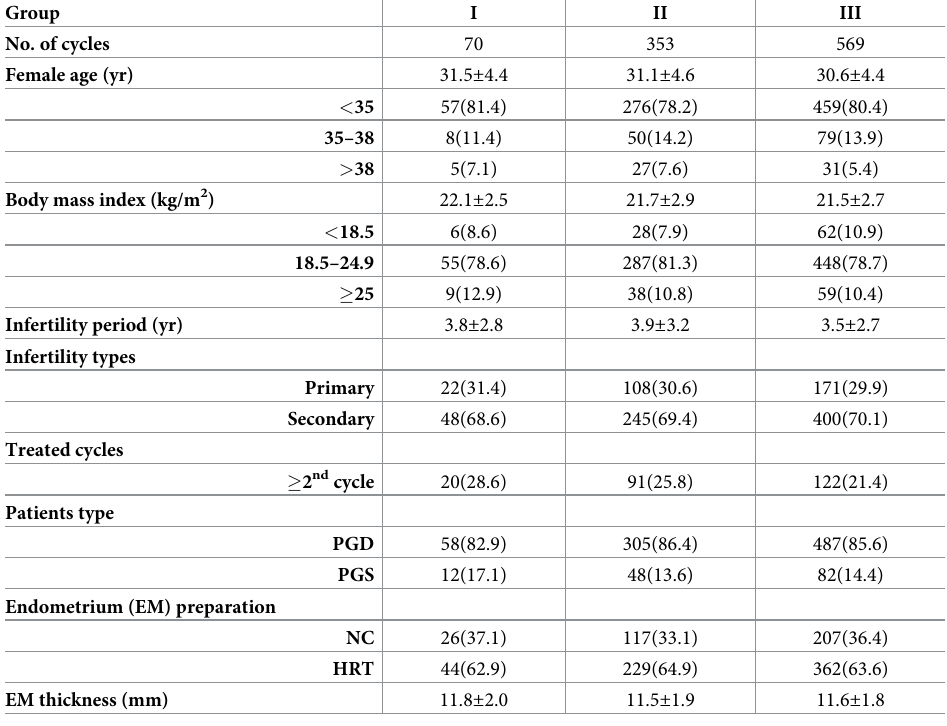
Table 3. Characteristics of PGD/PGS patients transferred a single blastocyst with different hatching types.